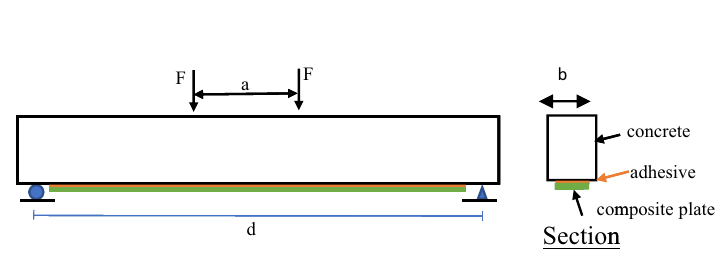
Figure 1: Setup of the strengthened concrete beam and fl exural four - point